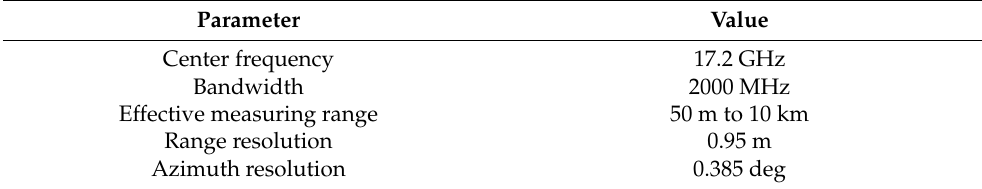
Table 1. The main parameters of GPRI-II.